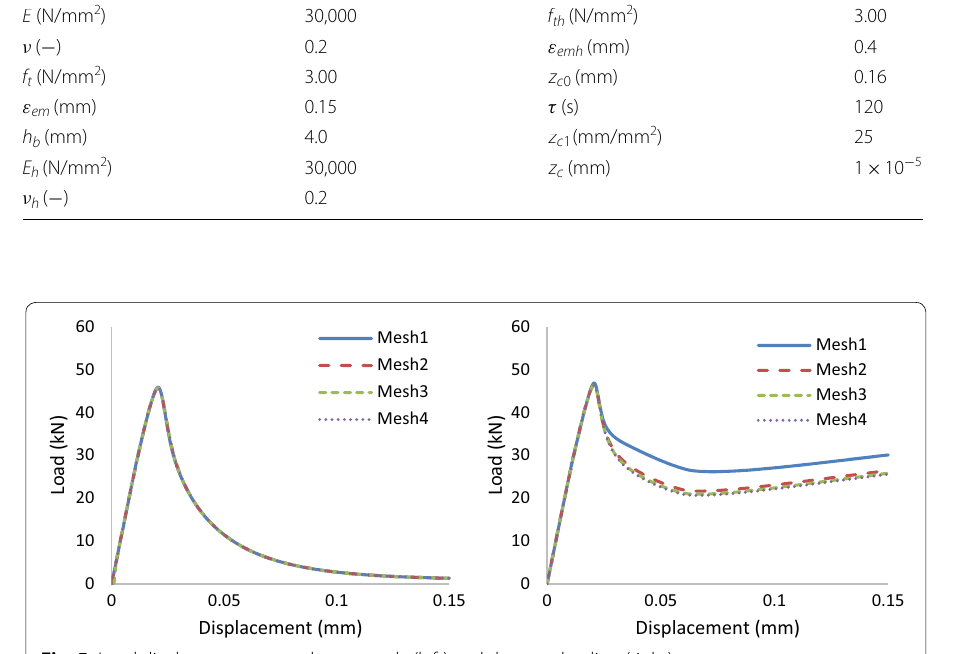
Fig. 5 Load displacement curve damage only (left) and damage‑healing